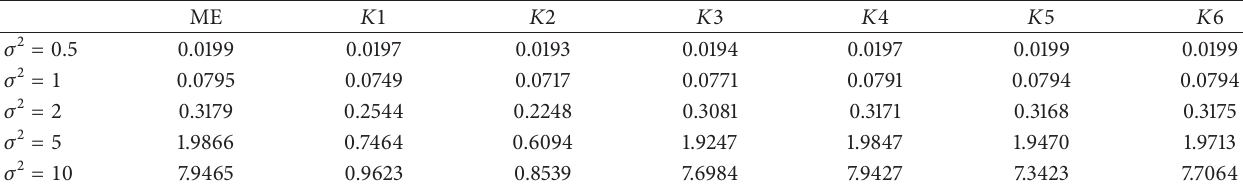
Table 8: Estimated MSE with 𝑛 = 100 , 𝑝 = 4 , and 𝛾 = 0.99 .